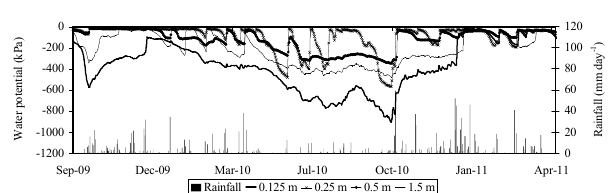
Fig. 7. Water potential and daily rainfall measured at the dune forest site.